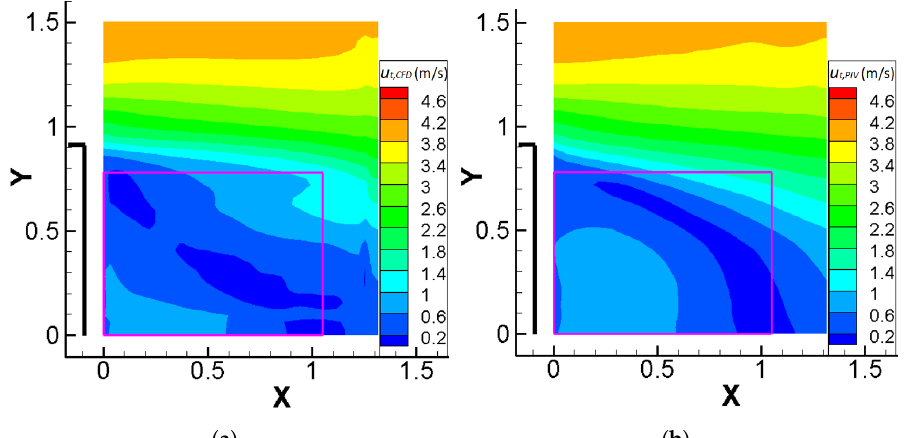
Figure 13. Contours of the total velocities, u t , CFD (m/s) and u t , PIV (m/s), on plane C, extracted by: ( a ) CFD methodology, ( b ) PIV. The solid boundary of the cube is denoted by the thick black line, while X and Y are non-dimensional coordinates. The pink box indicates the region, shown in Figure 14. Flow is from left to